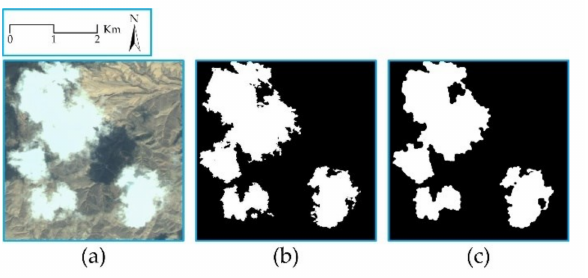
Figure 12. The cloud-detection result of traditional DL. ( a ) The original RGB image; ( b ) the ground truth; ( c ) the result of traditional DL. The coordinates of ( a ) are 118.4E and